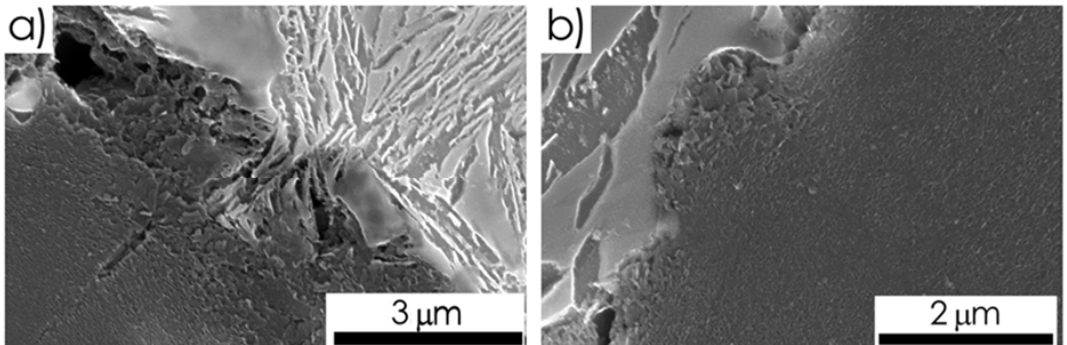
Figure 17. Morphology of the G-M interface, top pole area in spheroid near fracture surface (ADI cyclic specimen), SEM: ( a ) A micro-volume of matrix embedded in the spheroid surface rim, ( b ) initial stages of the G-M debonding, local cracks and shift of graphene plates.